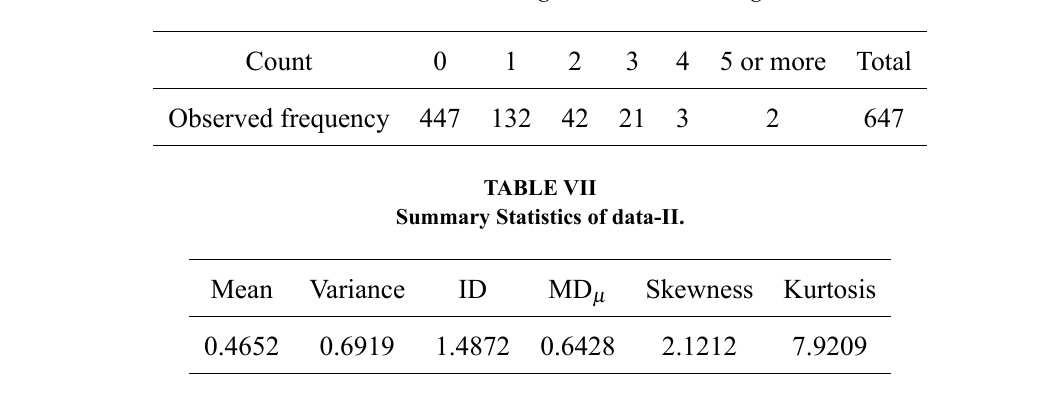
Accidents to 647 women working on H. E. shells during 5 weeks.